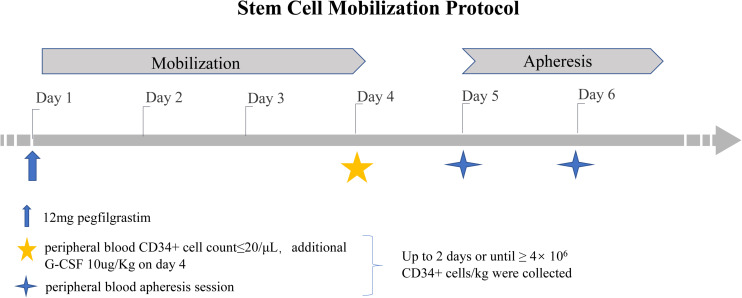
Biopsy examples.